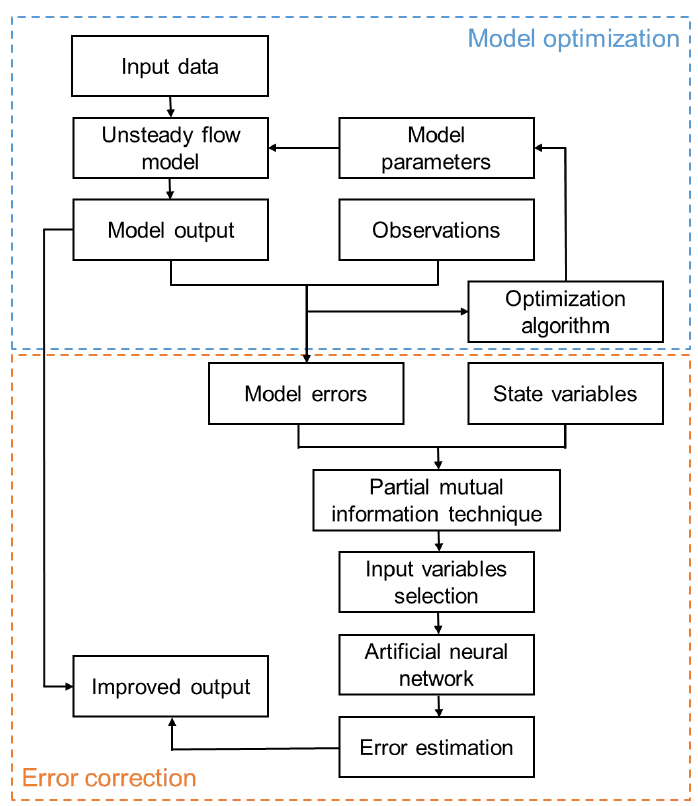
Figure 3. The flowchart illustrating the